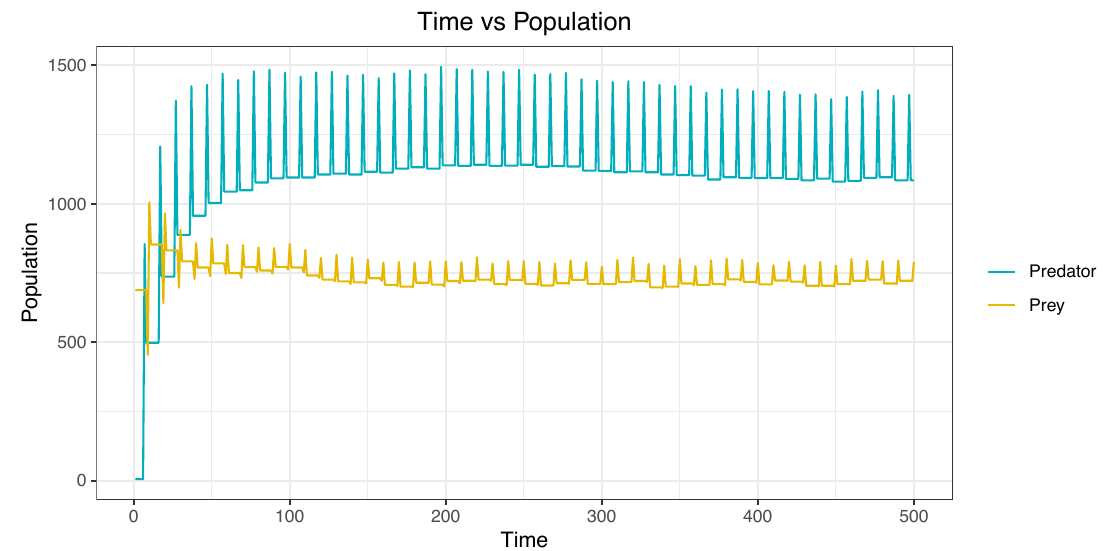
Figure 10. Simulation from the beginning to the end without using agents—Case E.